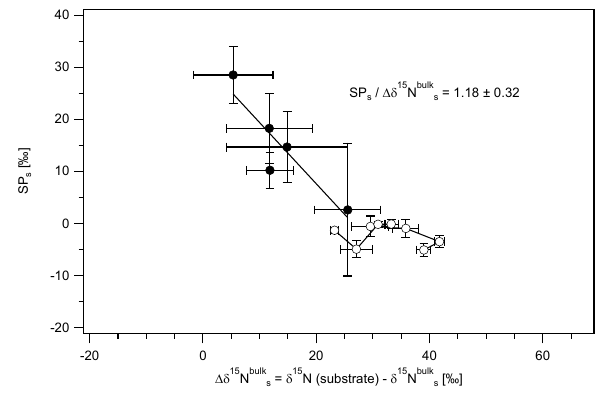
Fig. 6. SP s versus 1δ 15 N bulk s plot to interpret the biogeochem- istry of soil emitted N 2 O. Isotopic source signatures indicate het- erotrophic or nitrifier denitrification as the main N 2 O production process, with 1δ 15 N bulk s values between 5 and 42‰. Before fer- tiliser application (closed symbols, 9 to 22 September, periods with N 2 O concentration changes > 6.5ppb) a SP s / 1δ 15 N bulk s ratio of 1 . 18 ± 0 . 32 indicates N 2 O reductase activity which ceased after fertiliser addition (open symbols, 22 to 30 September) identified by low SP s values between 0 and − 5‰. For δ 15 N (substrate) 0‰ was assumed before fertiliser addition (before 22 Septem- ber), afterwards the 15 N content of the applied NH 4 NO 3 fertiliser (1 . 3 ± 0 . 3‰) was